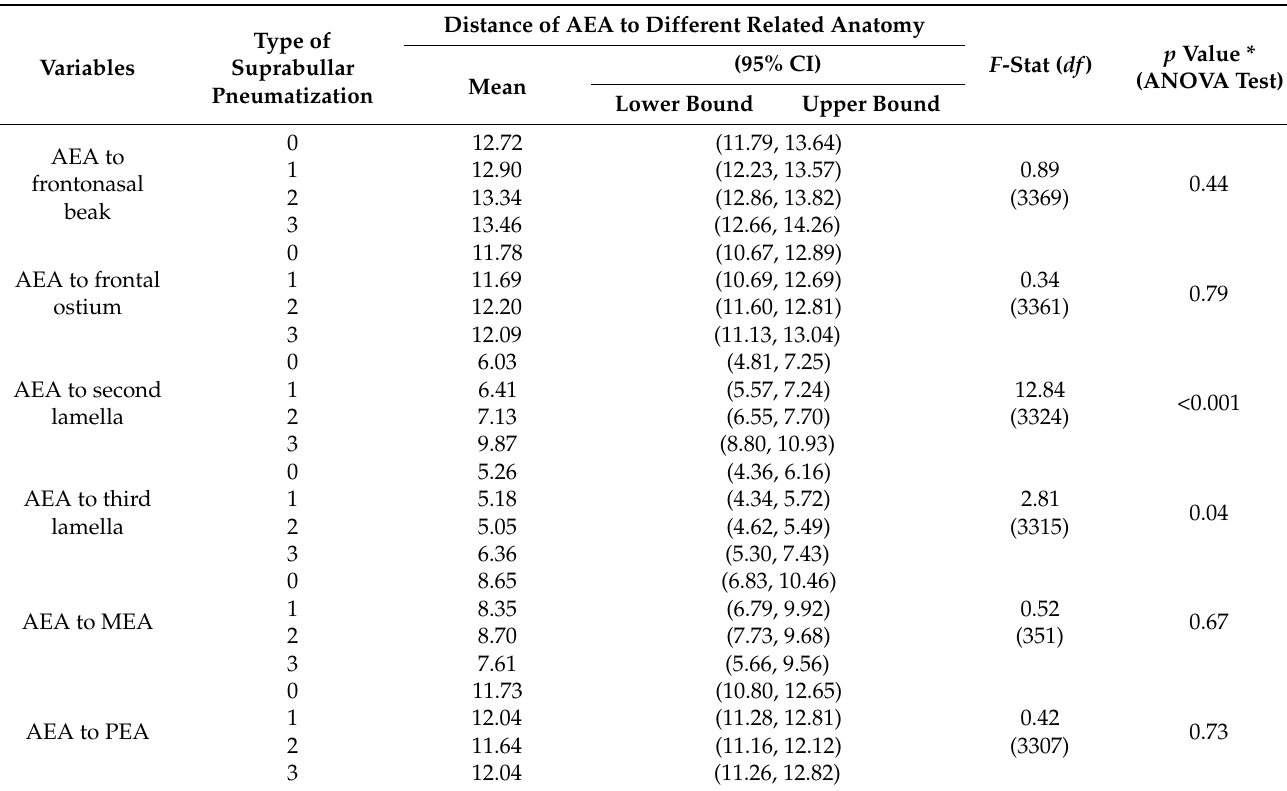
Table 2. The association of distance of anterior ethmoidal artery to the different related anatomical structures for each type of suprabullar pneumatization.